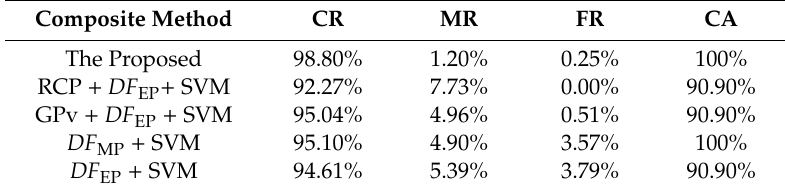
Table 3. Quantitative recognition performance for di ff erent composite